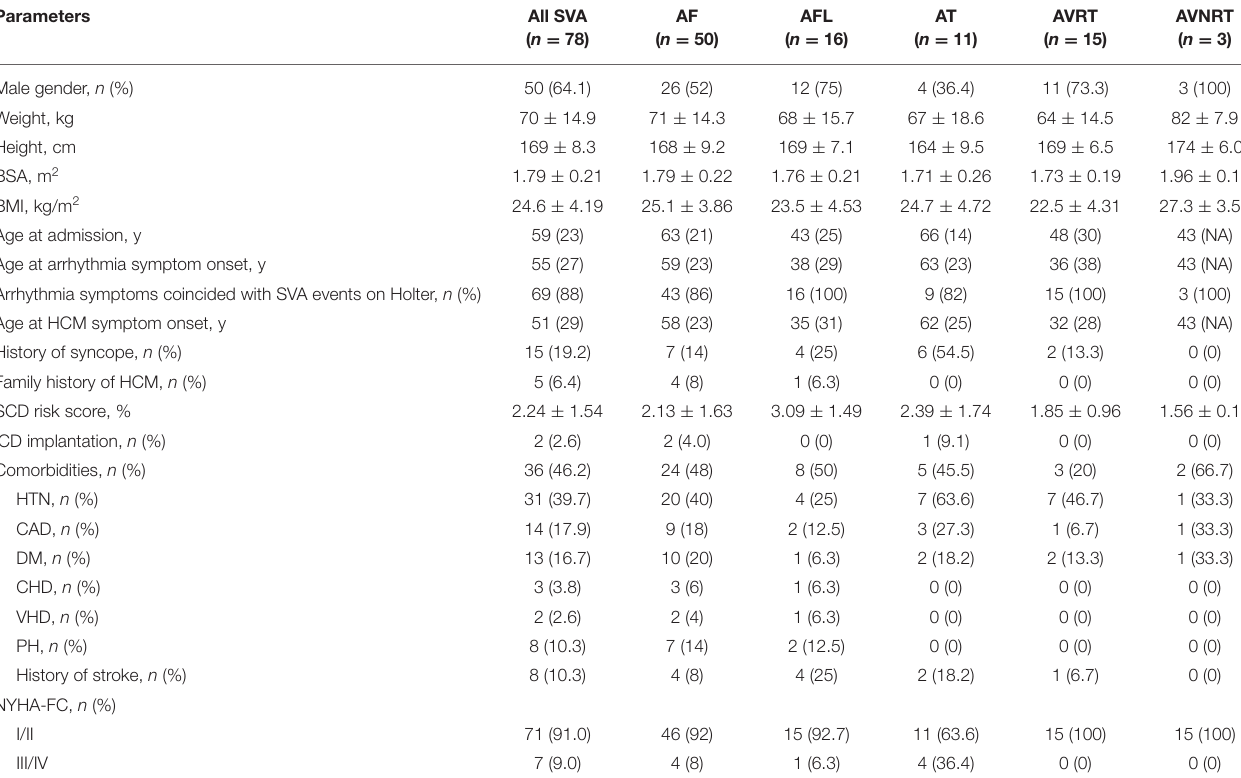
TABLE 1 | Demographic and clinical characteristics.